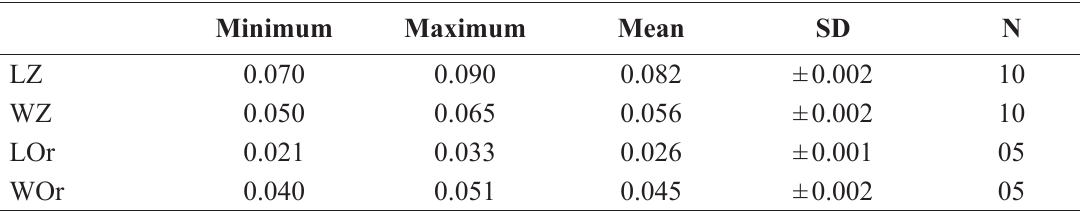
Table 11 . Measurements in mm of Skylonia sandbergi Sandberg, 1962 (GIS/B 0549 to 0569), Burdigalian, lower Miocene, Chhasra Formation, western Kachchh, Gujarat, India. Abbreviations: see Material and